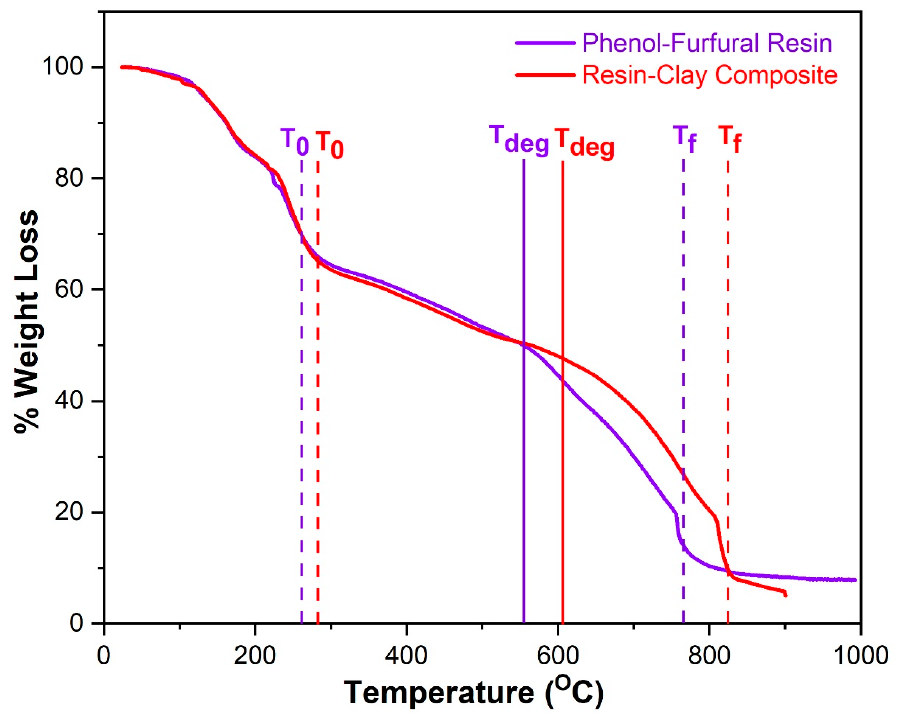
Figure 8. TGA thermogram of Phenol-furfural ( Munja ) resin and Phenol-furfural resin/organo modified MMT clay composite. Table 3. TGA results of phenol-furfural ( Munja) resin and phenol-furfural ( Munja) resin/organo modified MMT clay composite.